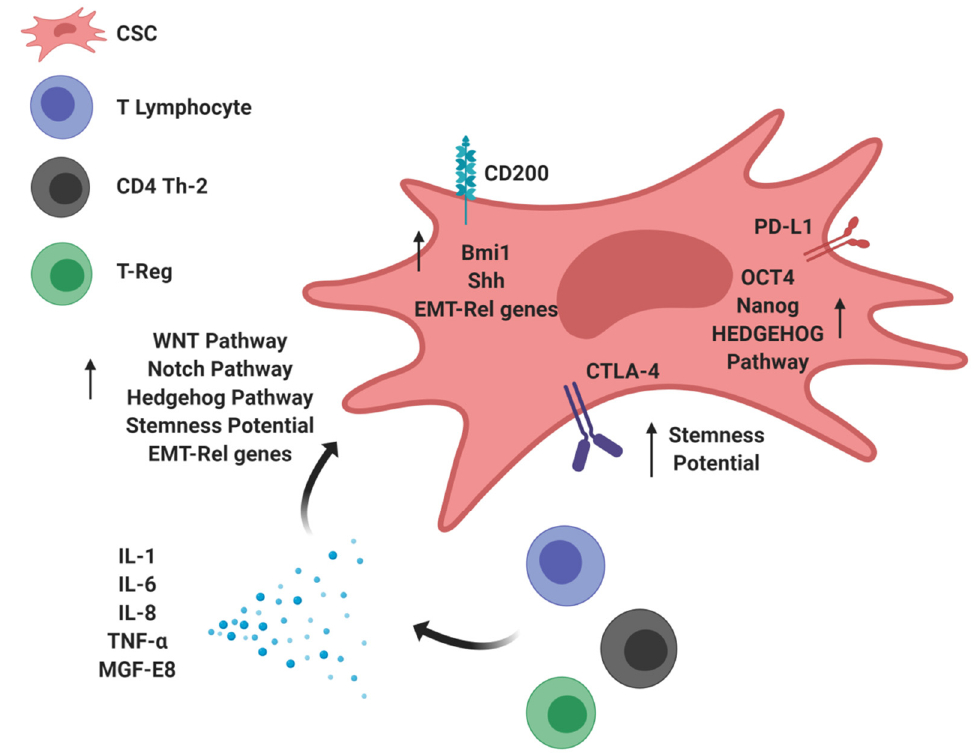
Figure 2. Schematic representing the core findings described in Section Altered expression of molecules involved in intratumor stemness enrichment (CD200, PD-L1, and CTLA-4) occurs via a “direct mechanism”. Dynamic crosstalk occurs between cancer stem cells (CSCs) and immune cells through the release of inflammatory soluble factors (IL-1, IL-6, IL-8, TNF- α , and MGF-E8) by tumor-infiltrating immune cells—a “reverse mechanism”—coupled with the activation of CSC-related signaling pathways (WNT, Notch, and Hedgehog) that sustain the epithelial-mesenchymal transition (EMT) program and CSC maintenance/activity. Created byBiorender.